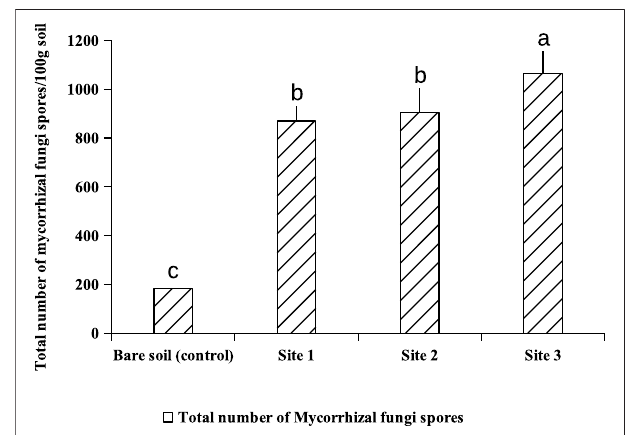
FIGURE1| Totalnumberofmycorrhizalsporesper100 gsoilindifferent rhizospheric soils of Acacia cyanophylla and in the control (bare soil) in the sandduneecosystemofEssaouira.Graphsindexedbythesameletterarenot signi fi cantly different at p < 0.05 according to Tukey ’ s test